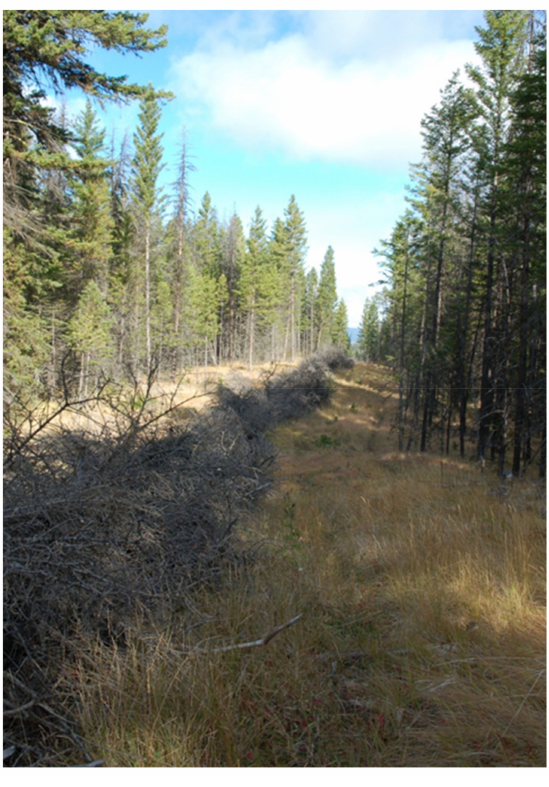
Figure 12. Length of woody debris fence. (Photo by A. Pantel).